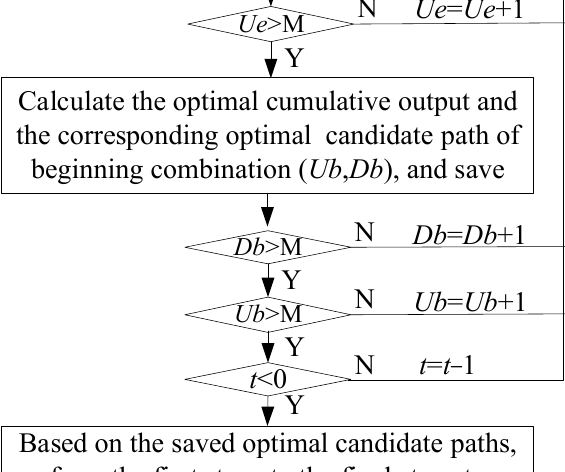
Figure 2. Reverse recursion procedure of multidimensional DP for joint optimal scheduling of cas ‐ cade reservoirs. 2.3. Dynamic Control Bound Construction of Yearly Drawdown Level The purpose of the yearly drawdown level optimization of the overyear regulation reservoir is to find the best water level at the end of the dry season and make rational use